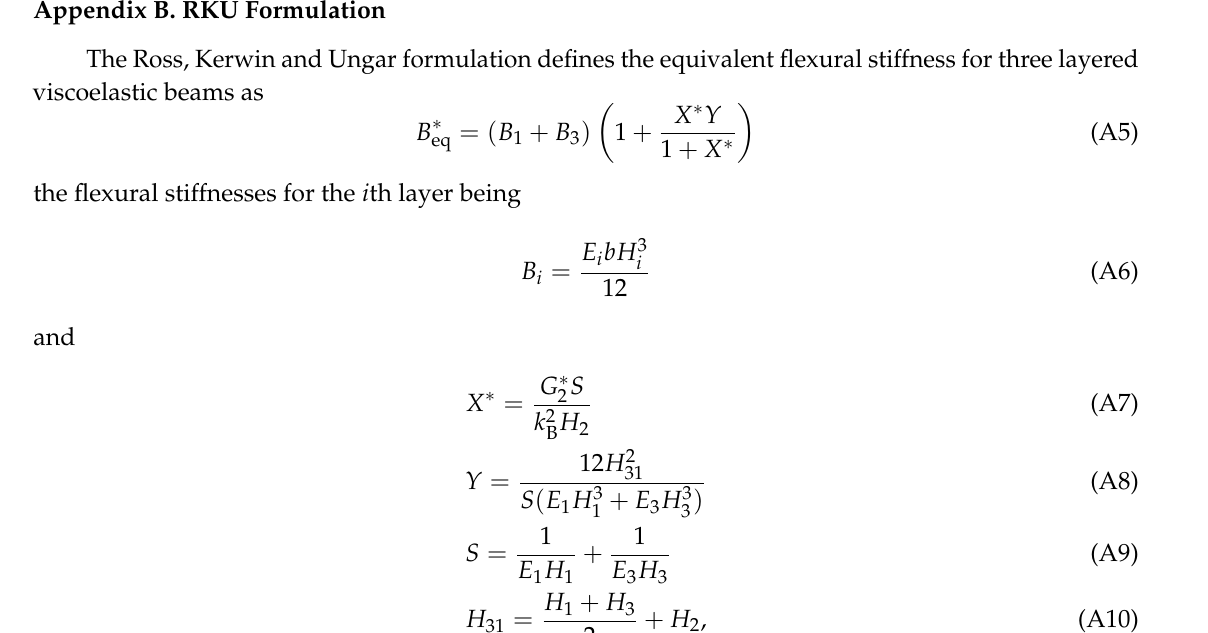
Figure A2. Plate element of size a displacement v and the rotations θ x and θ z